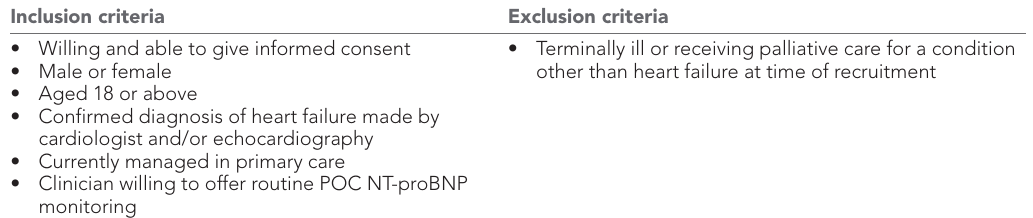
Table 2 Baseline characteristics of study participants. Comorbidities reported in less than five partici- pants have not been